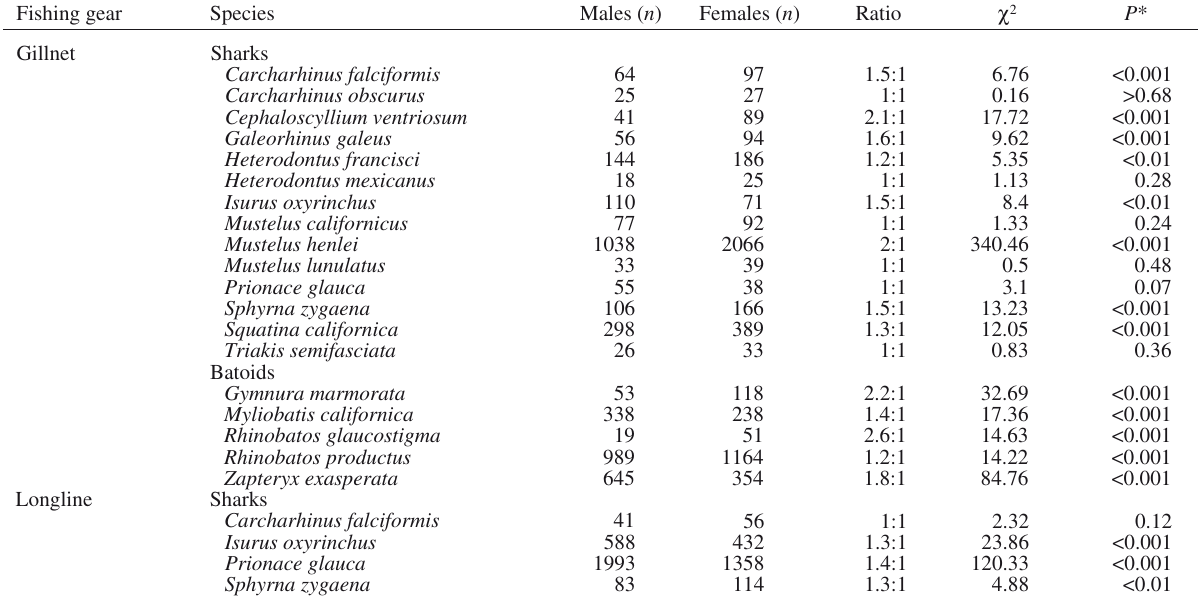
Table 6. – Sex ratios for the most common species of elasmobranchs captured by the artisanal fishery on the Pacific coast of Baja California Sur during the period 2000-2010. Fishing gear Species Males ( n )